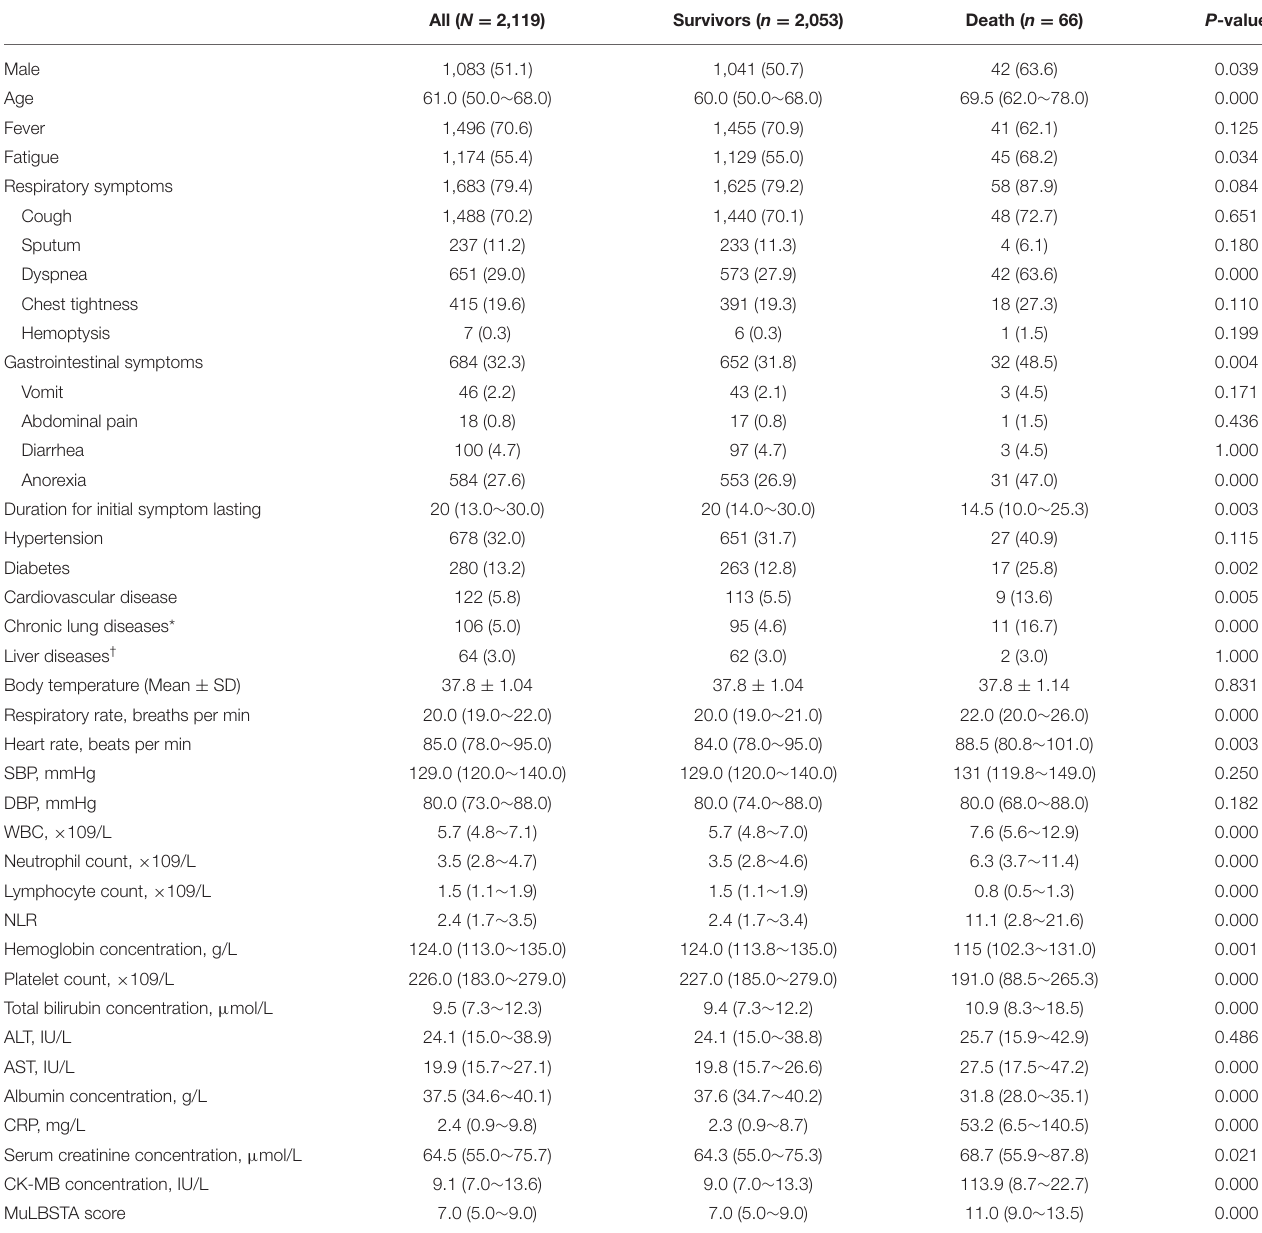
TABLE 1 | The demographics, clinical characteristics, vital signs, laboratory findings, and MuLBSTA score between the survivors and non-survivors with COVID-19 [ n (%)/median (25–75%)/mean ±